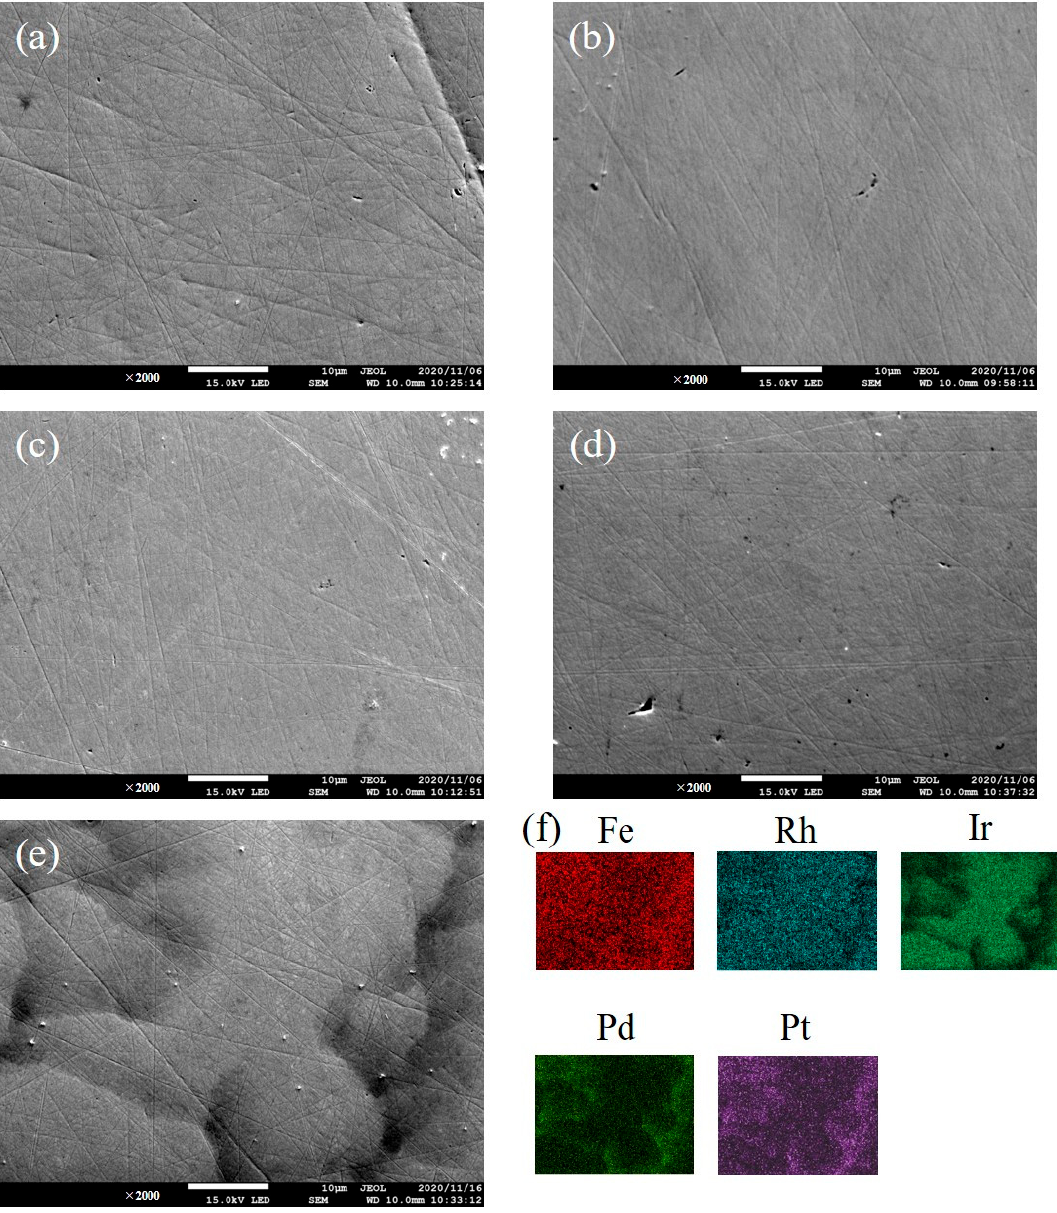
Figure 2. SEM images of ( a ) FeRh 4 , ( b ) FeIr 4 , ( c ) FePd 4 , ( d ) FePt 4 , and ( e ) FeRhIrPdPt, respectively. ( f ) Elemental mappings of FeRhIrPdPt.